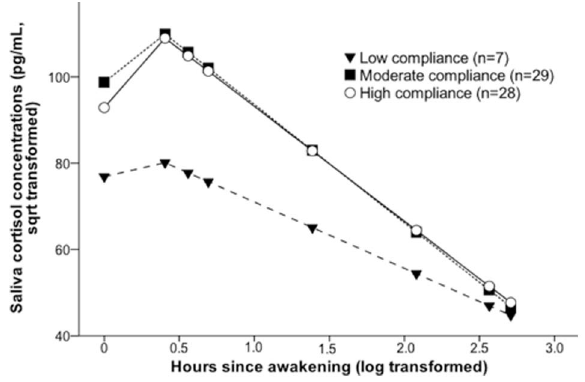
Figure 1. Cortisol concentrations in women with low, moder- ate, and high compliance. Saliva cortisol concentrations were averaged across two sampling days representing estimated values from a linear mixed